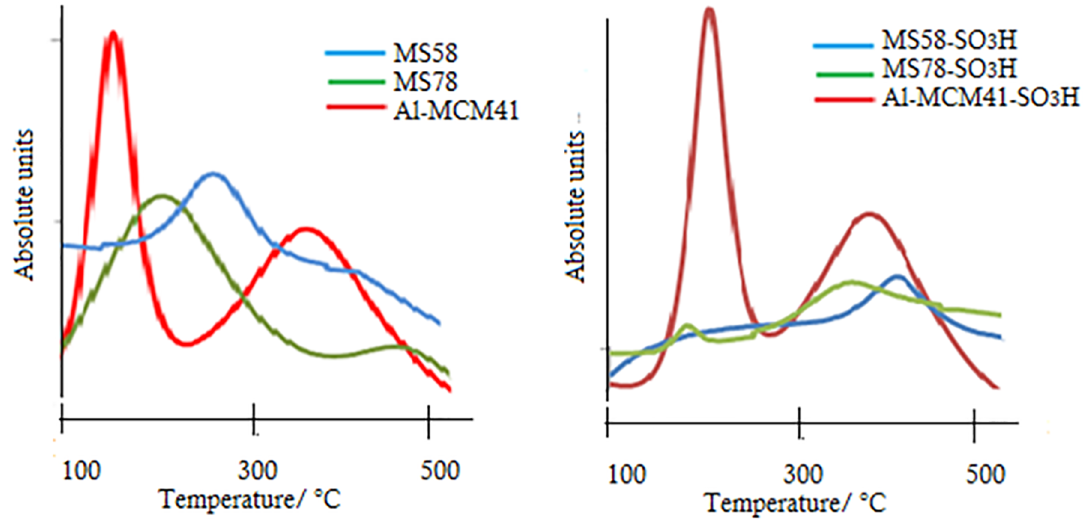
H reaction (time contact 12h at 3